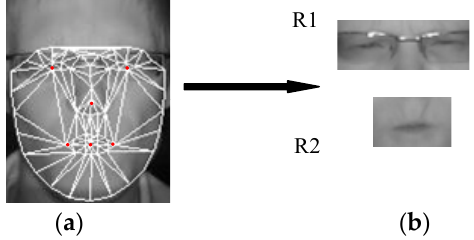
Figure 3. ( a ) The 68 facial points tracked by Conditional with Local Neural Fields (CLNF) ( b ) cropped upper and lower regions.